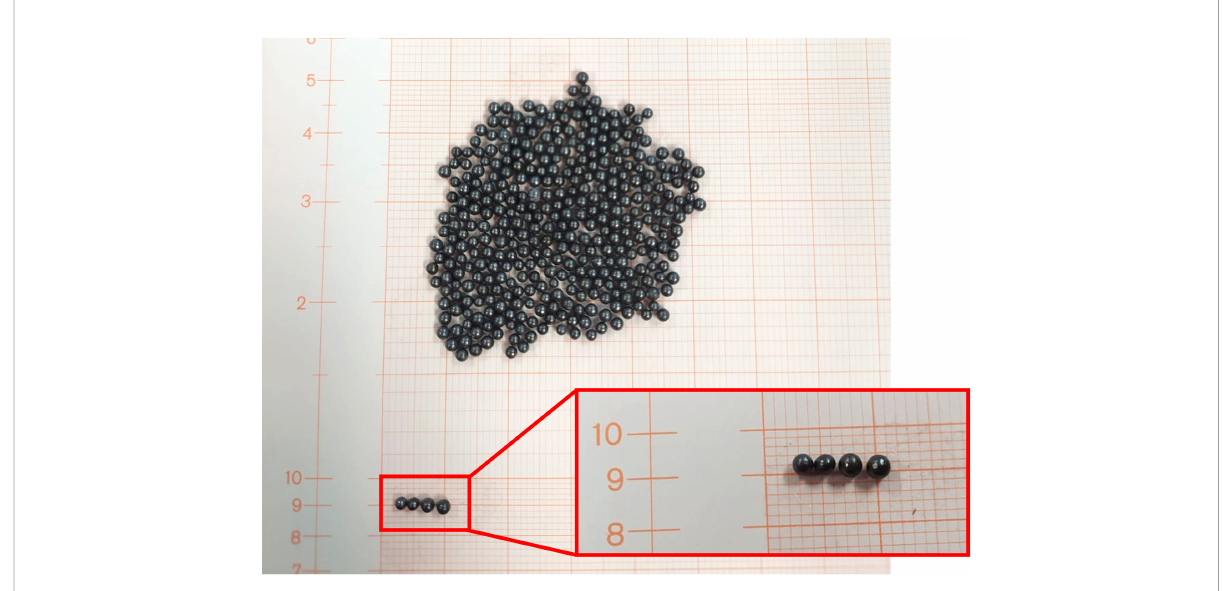
FIGURE 4 Lead spheres used to fi ll the 3D-printed allow lung blocks. Graph paper was used to point out the spheres